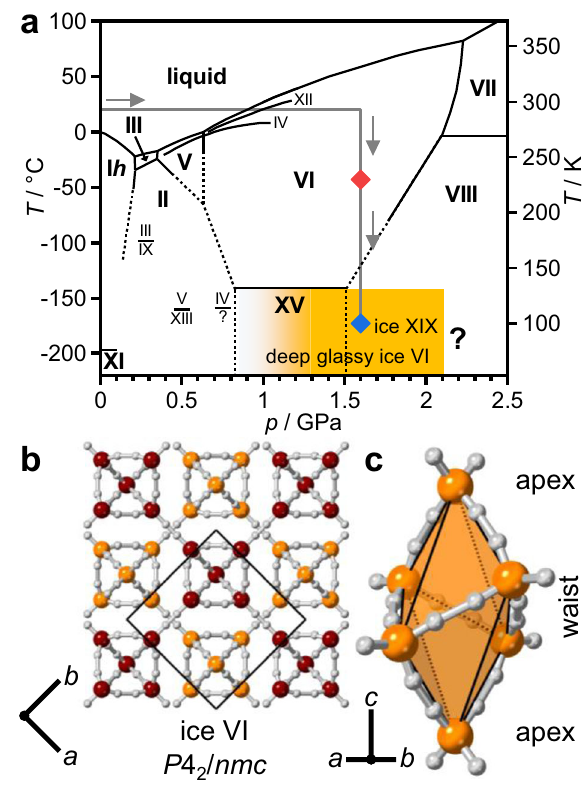
Fig. 1 Phase diagram of ice 1 and crystal structure of ice VI 9 . a The experimental pathway of the neutron diffraction experiment is highlighted by a thick grey line and the stable phases are shown with bold fonts. Solid and dashed black lines indicate experimentally measured and extrapolated phase boundaries, respectively. High-quality diffraction data were collected at 230 and 100 K at ~1.6 GPa as indicated by the red and blue diamonds. The formation of deep glassy ice VI starts gradually above 1.0 GPa as indicated by the orange-shaded area. b The hydrogen atoms of the ice VI structure are shown in white, and the oxygen atoms of the two individual networks in burgundy and orange, respectively. The unit cell is indicated by a black square and the crystallographic axes are de fi ned below the crystal structure. c Hexameric unit which is the basic building block of an ice VI